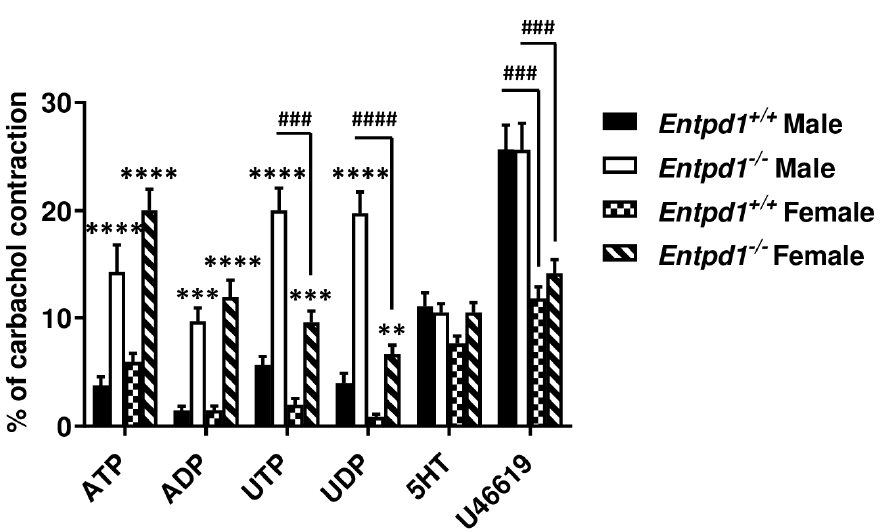
Figure 4. Contractile effect of extracellular nucleotides on male and female mouse bladder strips. Data presented are mean ± SEM of 20 contraction experiments with Entpd1 +/+ (wild type) and Entpd1 − / − (NTPDase1 deficient) male bladders and 15 with Entpd1 +/+ and Entpd1 − / − female bladders. Two symbols p < 0.01, three symbols p < 0.001, and four symbols p < 0.0001. * Contraction of Entpd1 − / − mice compared to that of wild type strips and # contraction of male strips compared to female strips of the same genotype. ATP, ADP, UTP, and UDP were used at a concentration of 100 µM, 5-hydroxytryptamine (5HT) at 10 µM, and U46619 at 100 nM.